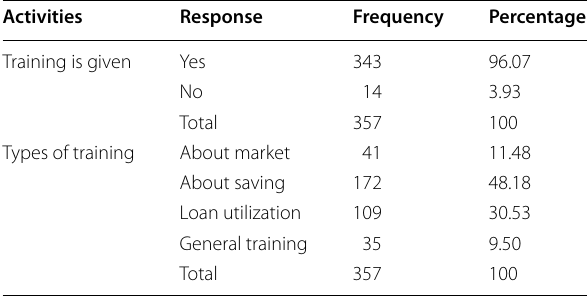
Table 7 Respondents about training. Source : Author’s Survey Activities